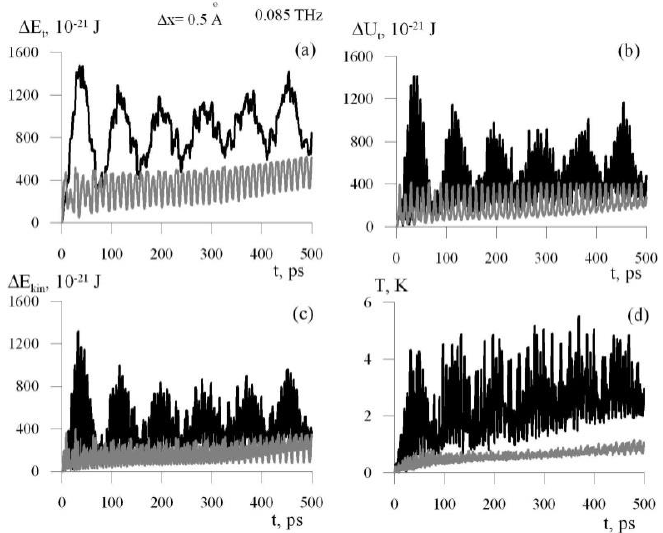
Fig. 6. Time dependence energy characteristics of the system under the cyclic loading:  x 0 = 0.5 Å,  =0.085 THz. (а) – amplification of the total energy of the system; (b) – amplification of the potential energy of atomic interaction; (c) – amplification of the thermal energy; (d) – the temperature found via the energy of thermal chaotic motion of atoms. Black line is the perfect crystal; grey line is the amorphized